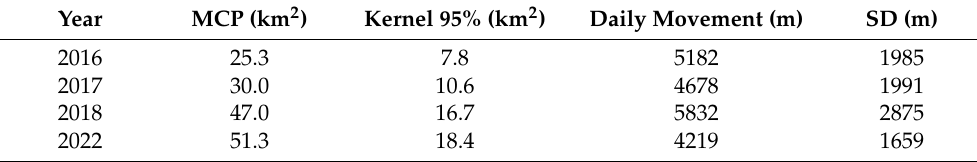
Table 2. MCP, kernel 95%, and daily movement values in the monitored summer